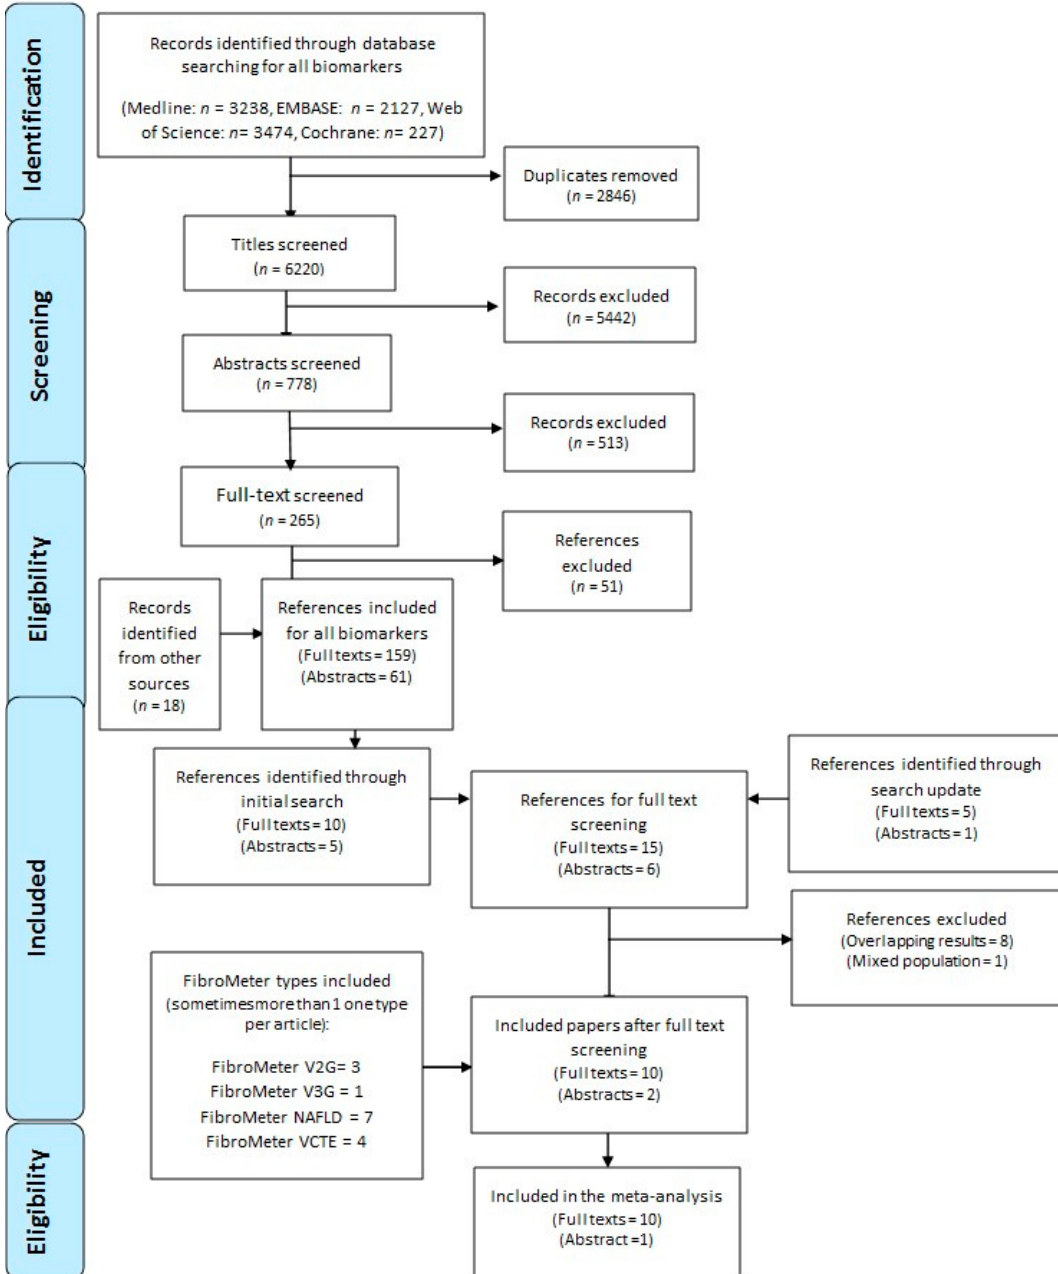
Figure 1. PRISMA Flow Diagram of primary studies.